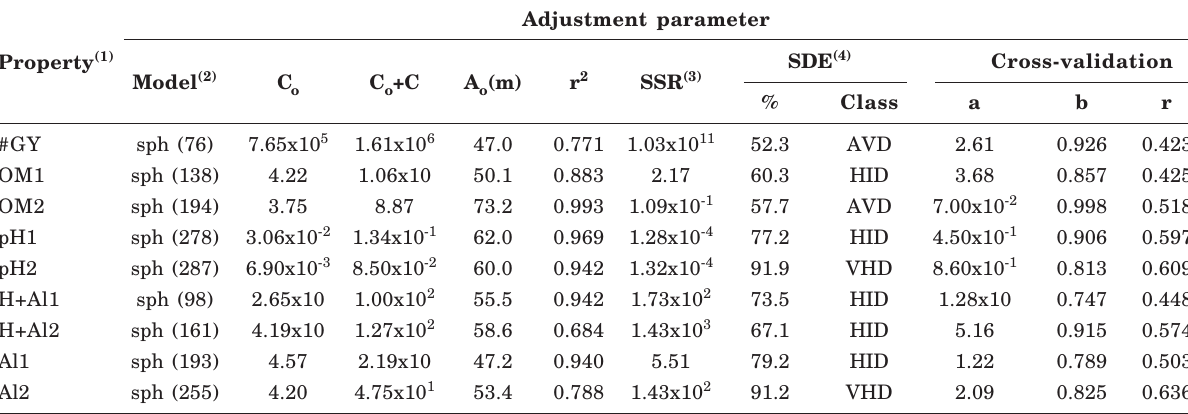
Table 5. Parameters of simple semivariograms of rice grain yield and some chemical properties of Typic Acrustox under